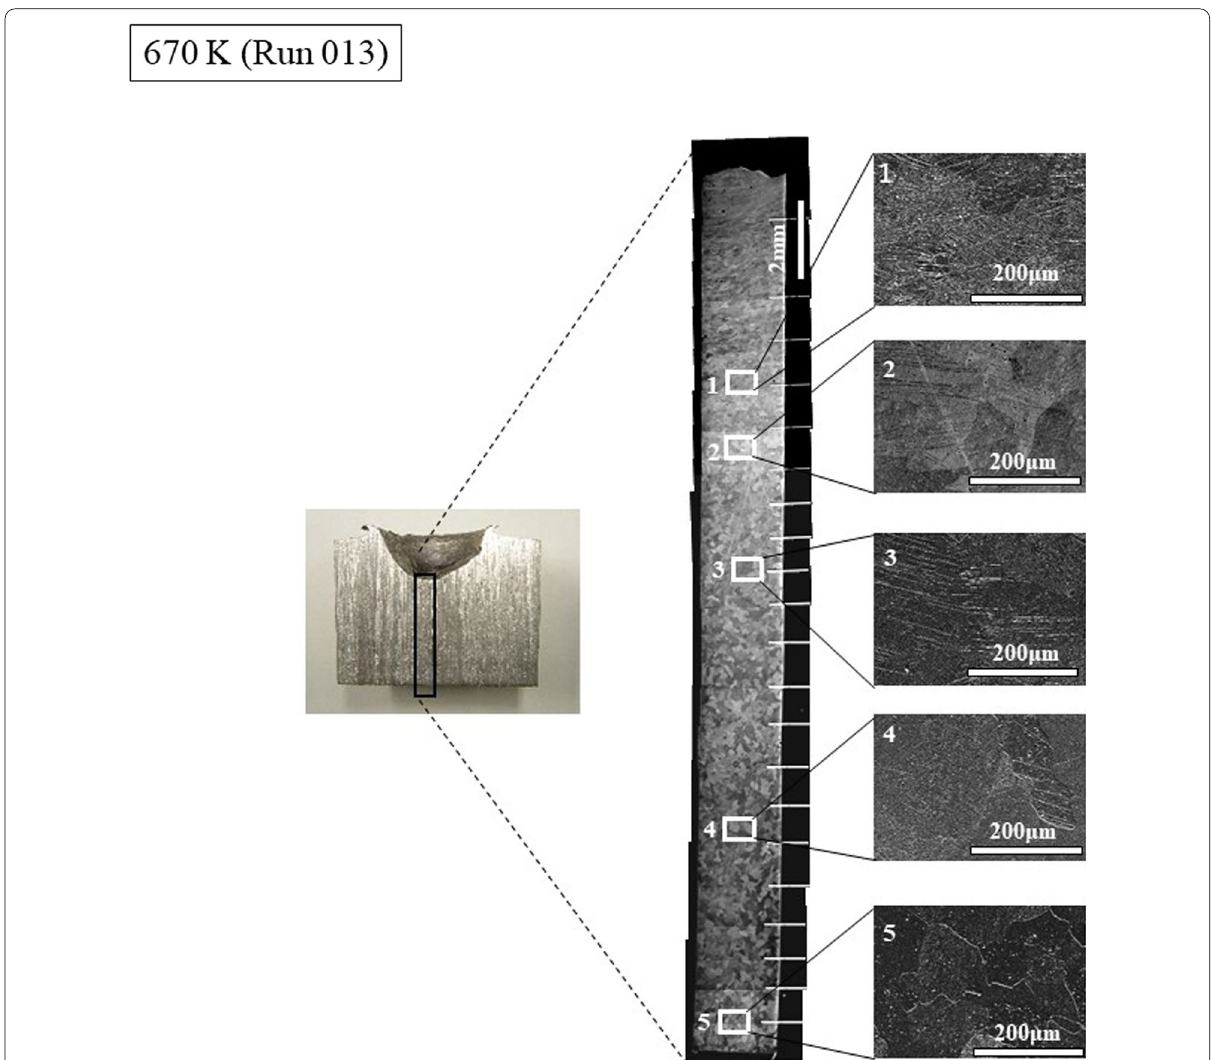
Fig. 8 The optical and backscattered electron (BSE) images of the sample impacted at 670 K (Run 013) and the secondary electron images (SEI) magnified